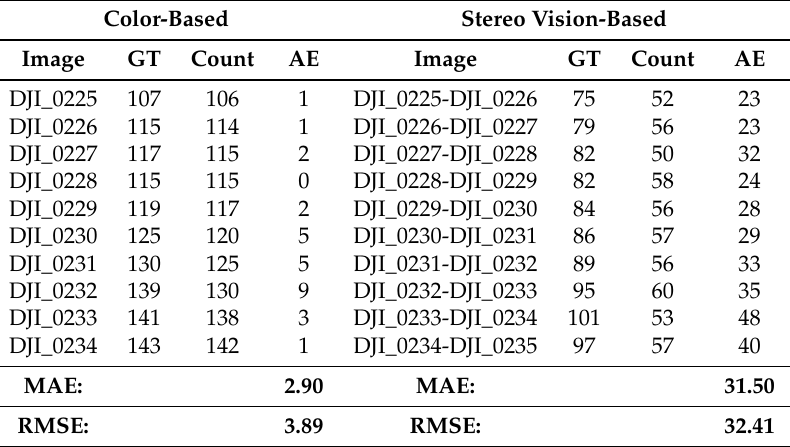
Table 1. Comparison of the number of olive trees counted by the color-based and the stereo vision-based segmentation algorithms. Results are compared with respect to the number of hand-annotated olive trees (GT: ground-truth, AE: absolute error, MAE: mean absolute error, RMSE: root mean squared error).